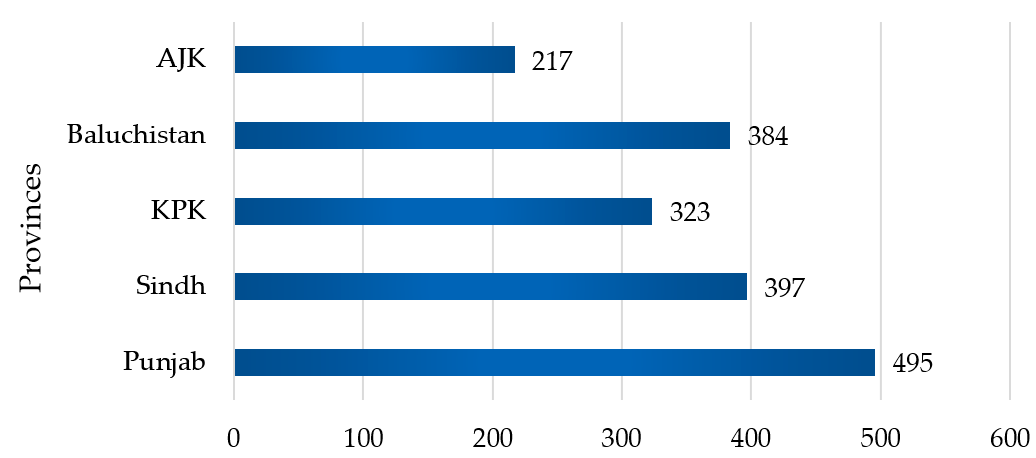
Figure 8. Provincial share of electricity generation and consumption of Pakistan [40,41].